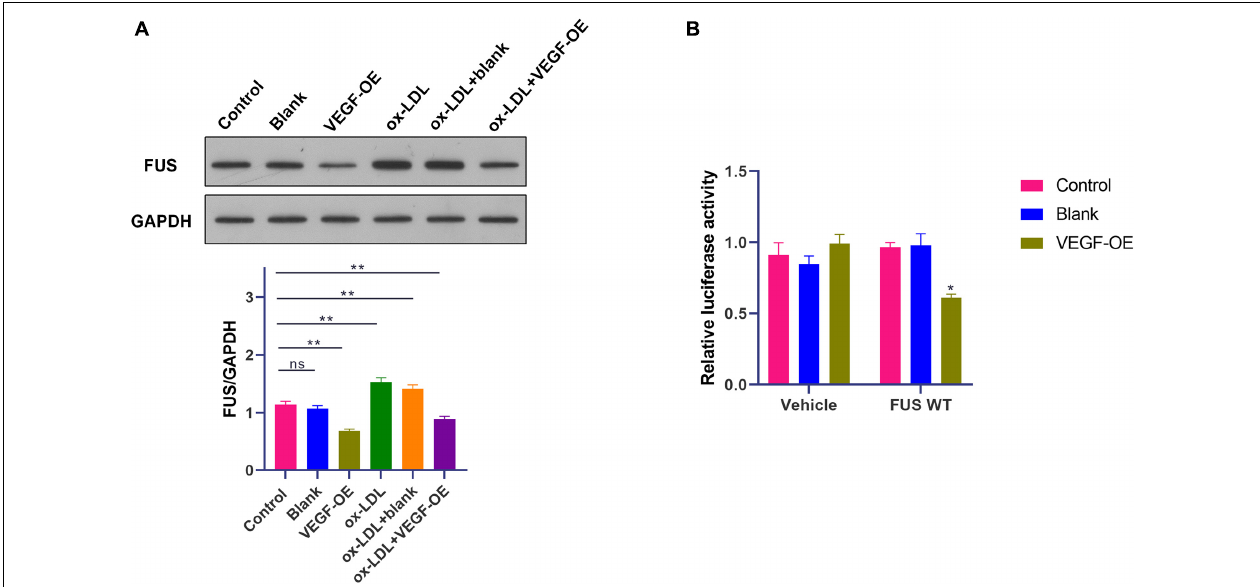
FIGURE 6 | A negative feedback regulation of FUS expression by VEGF in HUVECs. (A) The protein level of FUS in HUVECs transfected with blank vector or VEGF expression vector under ox-LDL treatment. (B) Translation activity of FUS analyzed by relative luciferase reporter activities in HUVECs transfected with blank vector or VEGF expression vector. Blank, blank vector; OE-VEGF, VEGF overexpression. N = 3. * p < 0.05, ** p < 0.01 vs. control group.